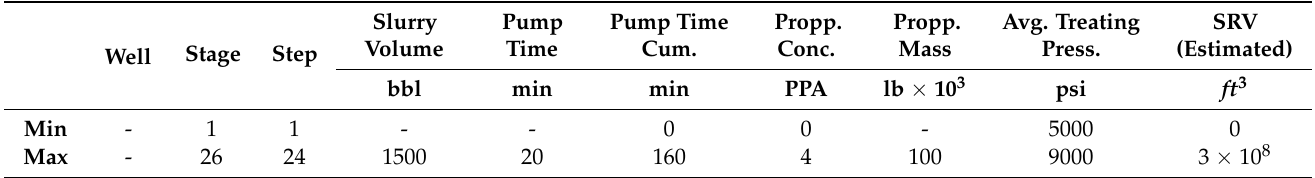
Table 3. The final set of input/output. The maximum calculated SRV in this study is about ~14 times bigger than what was reported in Barnett shale